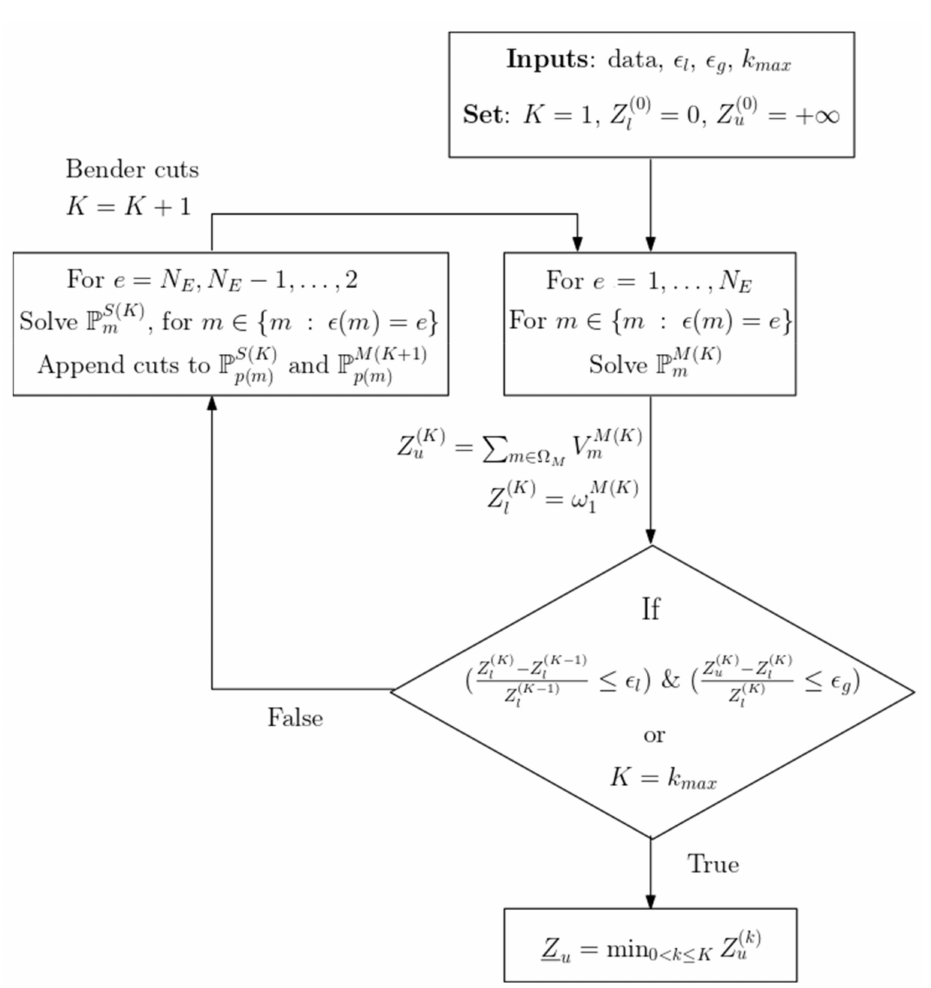
Figure 1. Diagram of the decomposition algorithm. The convergence criterion assessment is always performed after the completion of step 1 of the algorithm. The algorithm returns a lower and an upper bound to the optimal cost of the original problem. The solution with the smallest upper bound Z approximation of the optimal solution, and its degree of optimality is certified by